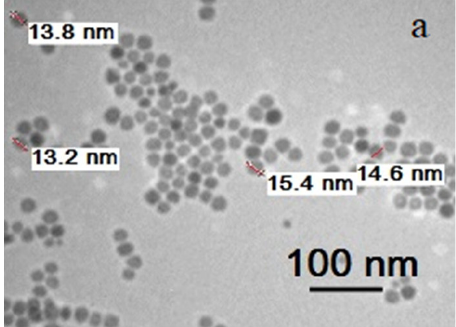
Figure 3. TEM image of the initial Fe 3 O 4 NPs ( a ) and XRD patterns for Fe 3 O 4 and Fe 3 O 4 @C NPs ( b ).